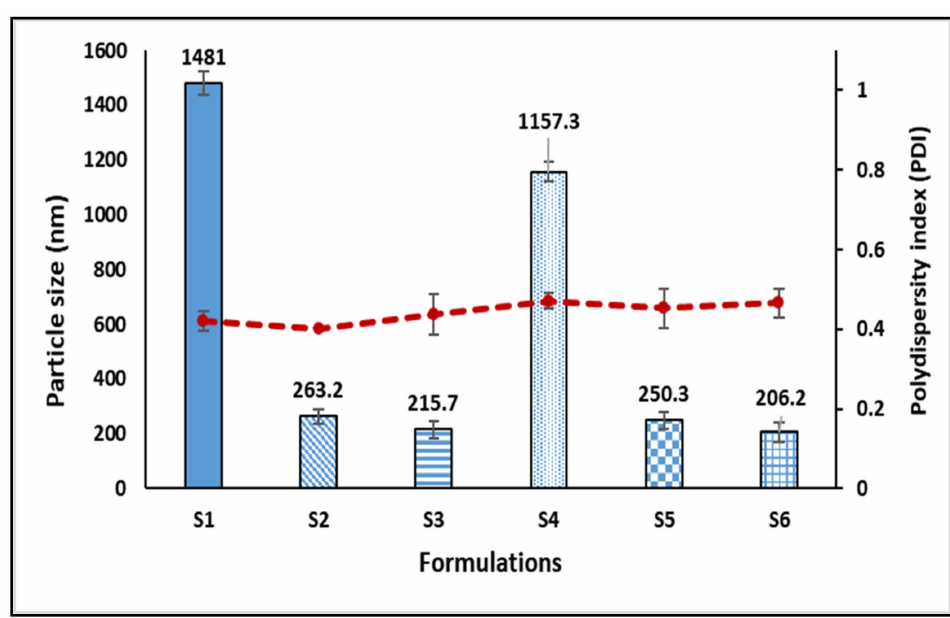
Figure 1. The particle sizes and PDI values for IBU nanoconjugates S1–S6.